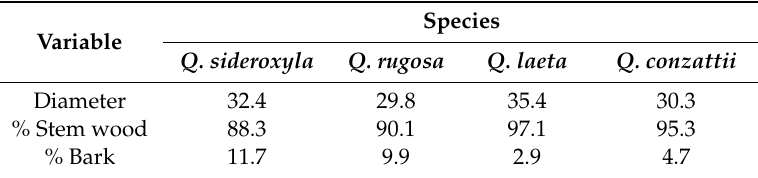
Table 1. Average diameter, stem-wood, and bark proportion of the transversal section of four Quercus